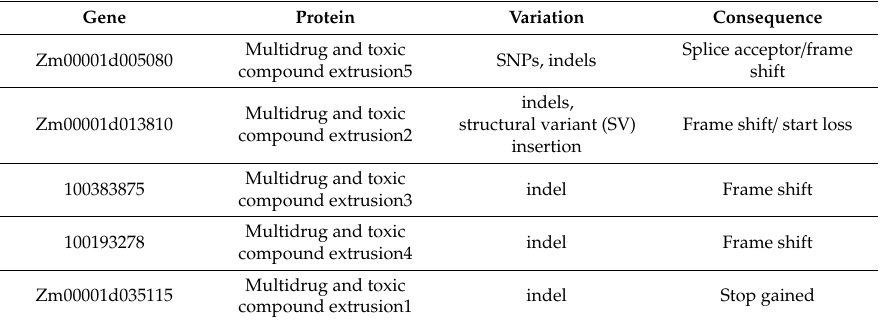
Figure 6. Genetic variations in phosphate transporter genes.